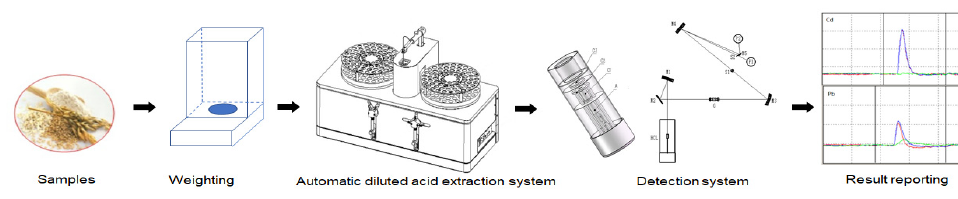
Figure 5. Flow chart of the simultaneous determination of Pb and Cd in cereals with an automated diluted acid extraction system.